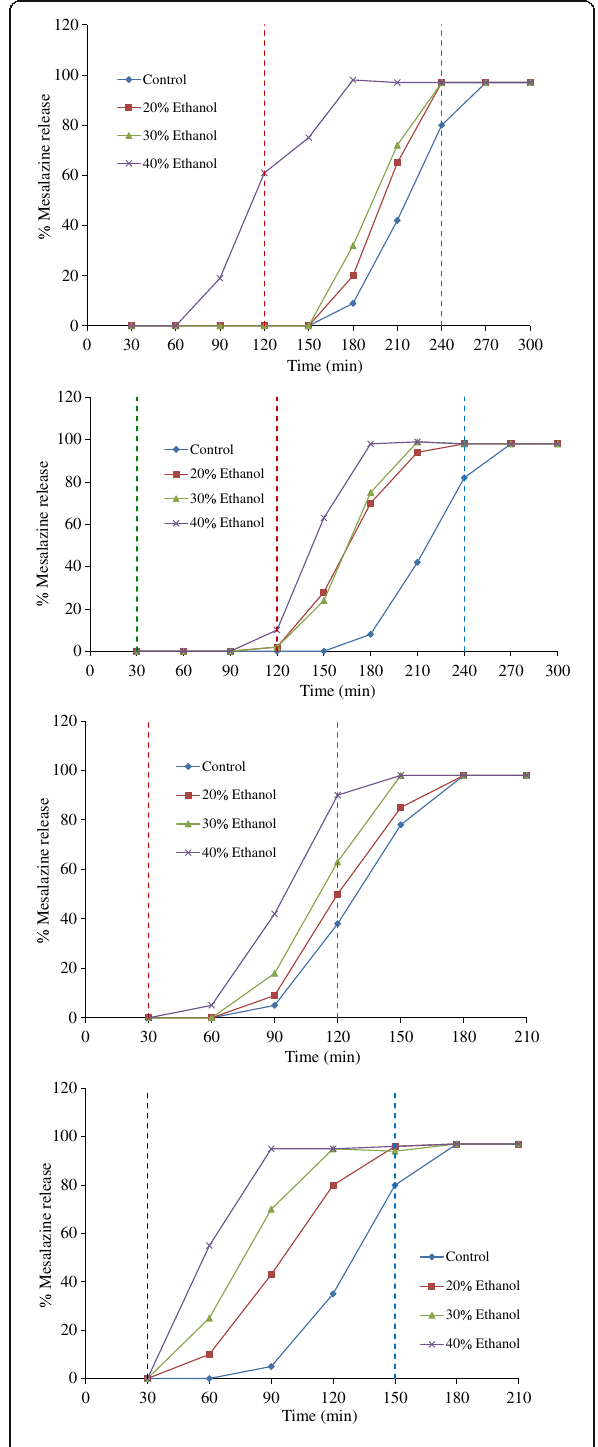
Fig. 15 Dissolution of Salofalk tablets ( red dotted line represents change from 0.1 M HCl with ethanol to pH 6.8 phosphate buffer, blue dotted line represents change from pH 6.8 phosphate buffer to pH 7.4 phosphate buffer, green dotted line represents change from 0.1 M HCl with ethanol to 0.1 M HCl with no ethanol, black dotted line represents change from 0.1 M HCl with ethanol to pH 6.8 phosphate buffer where only the first 15 min contains ethanol equivalent to half the concentration in acid) (data from reference (Fadda et al.